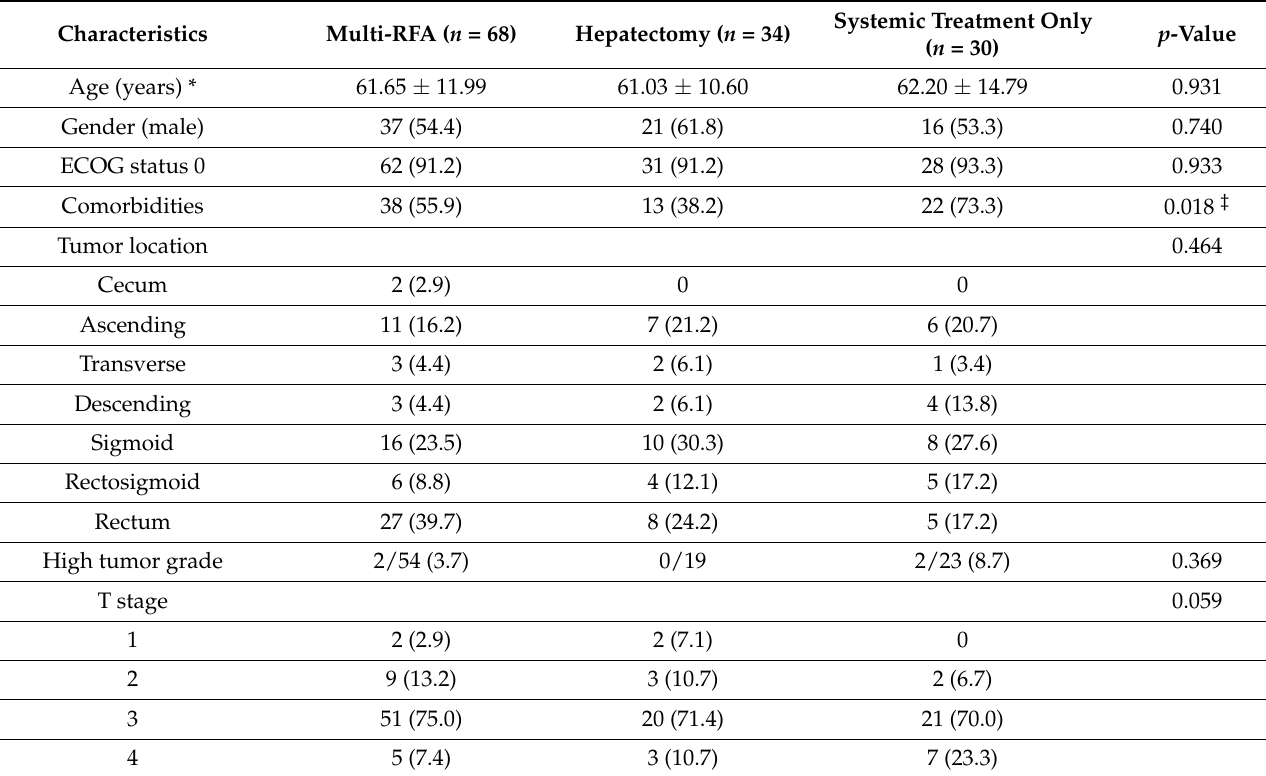
Table 1. Clinicopathological characteristics before